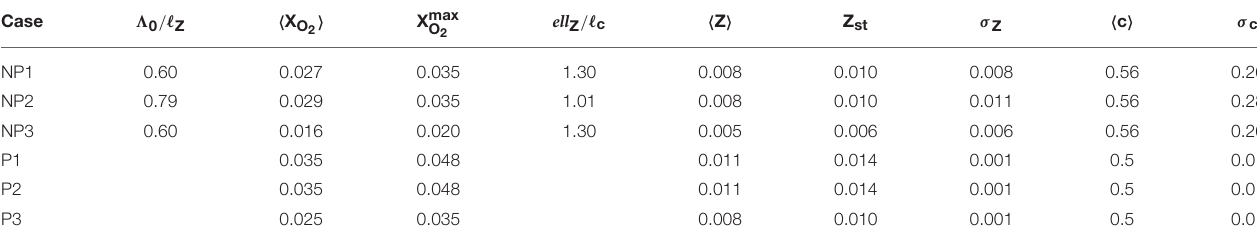
TABLE 2 | DNS initial